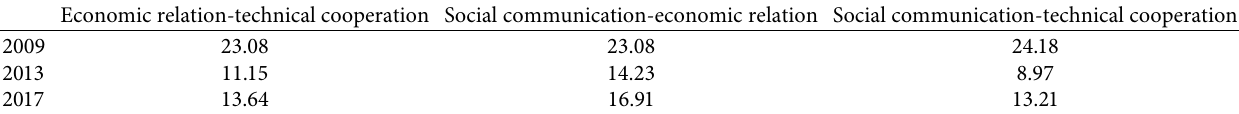
Table 5: Similarity degree of refrigeration firms network in Minquan